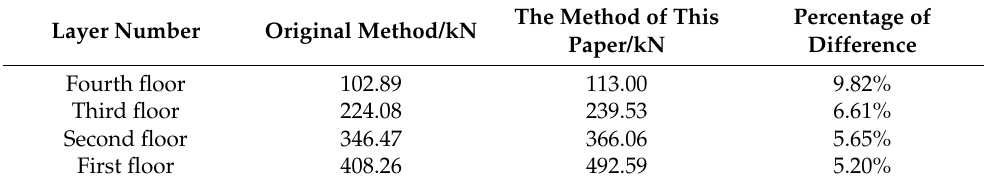
Table 6. Calculation results of pullout force of anchor-plates in example